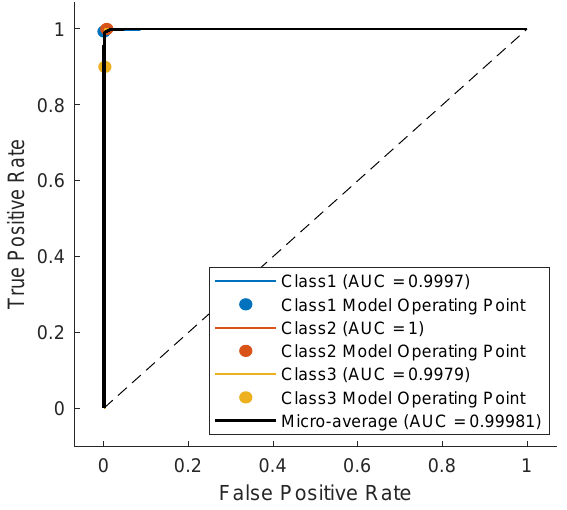
Figure 9. Confusion matrix of the TCN model proposed in Experiment 1 of Table 1, applied to the ECG5000 dataset excluding classes SP and UB.